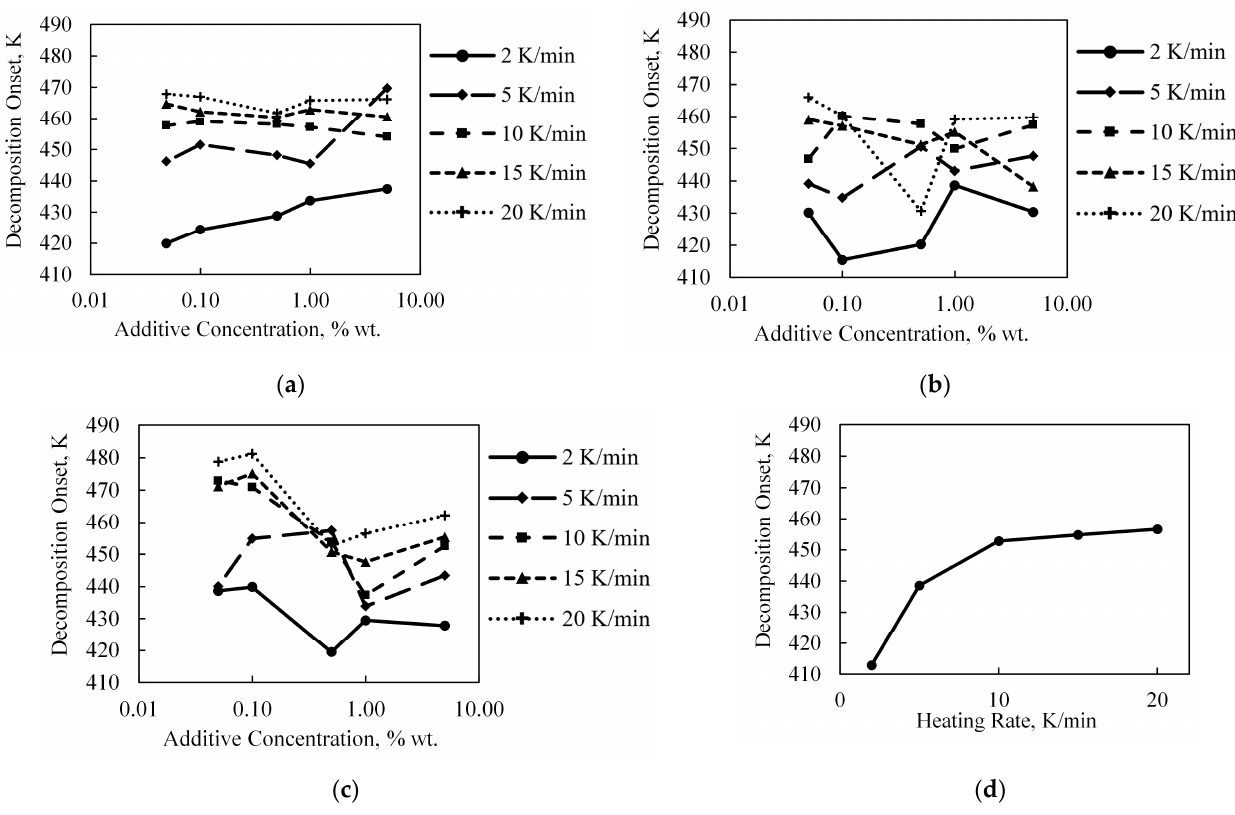
Figure 6. Decomposition onset temperatures of 90% HAN with and without additives: ( a ) Bipy; ( b ) TEA; ( c ) EDTA; ( d ) 90% aqueous HAN without additive.